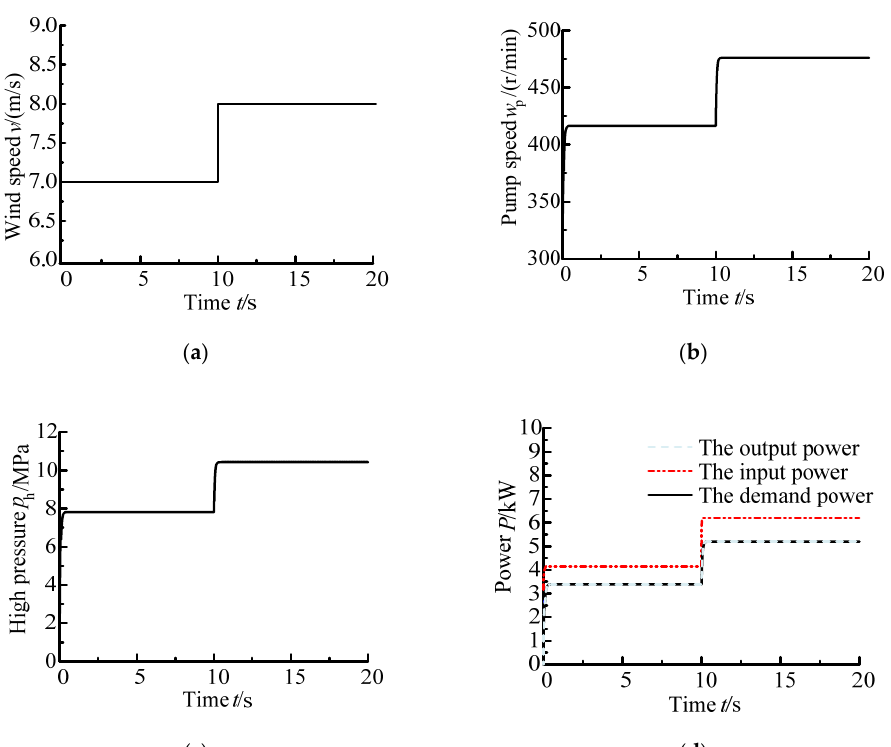
Figure 6. The response curve under the condition of 7 m/s-8 m/s step wind speed at 10 s. ( a ) the wind speed; ( b ) the pump speed; ( c ) the high pressure; ( d ) the output power. Under the condition of 8 m/s–7 m/s step wind speed at 10 s, the response characteristics of system are observed during the process of the power tracking, and the specific curves are shown in Figure 7.